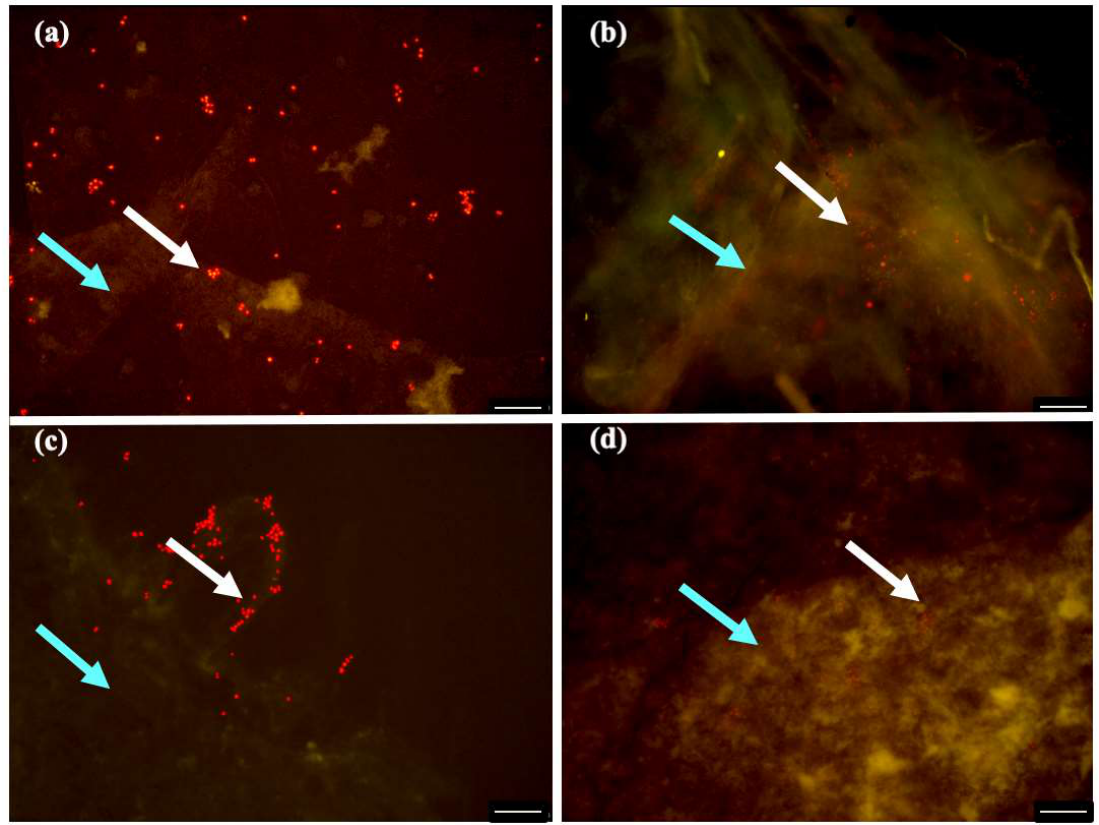
Figure7. Fluorescencemicrographsshowingtheviabilityof C.debaryana cells(whitearrow)immobilized Figure 7. Fluorescence micrographs showing the viability of C. debaryana cells (white arrow) in biofilms (blue arrow) produced at 30 ◦ C and after 14 day of incubation, in di ff erent HS:BG-11symbiotic immobilized in biofilms (blue arrow) produced at 30 °C and after 14 day of incubation, in different media ratios: ( a ) 55:45; ( b ) 60:40; ( c ) 70:30 and ( d ) 80:20. Scale bar, 100 µ HS:BG-11symbiotic media ratios: (a) 55:45; (b) 60:40; (c) 70:30 and (d) 80:20. Scale bar, 100 μm.